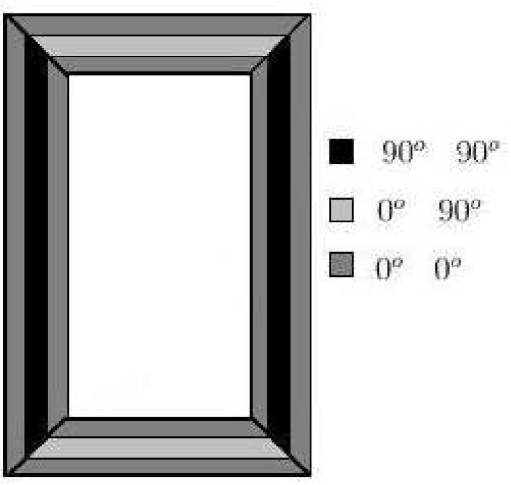
Figure 5. Thin-walled composite beam cross section.